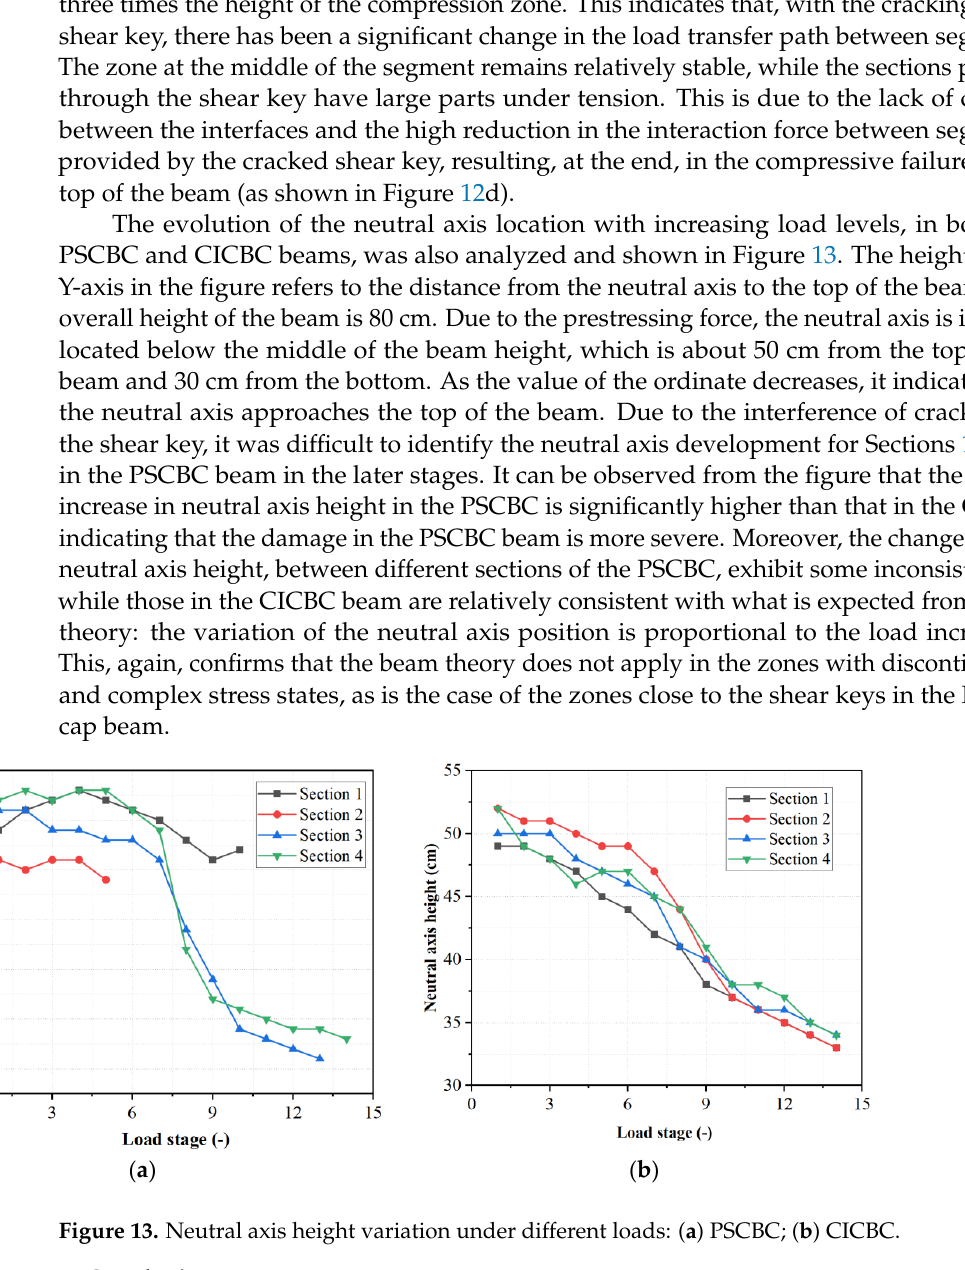
Figure 12. Evolution of shear key cracking at different damage levels and failure modes of the seg- mental beam: ( a ) elastic state; ( b ) elastoplastic state; ( c ) plastic state; ( d ) concrete crushing at the top